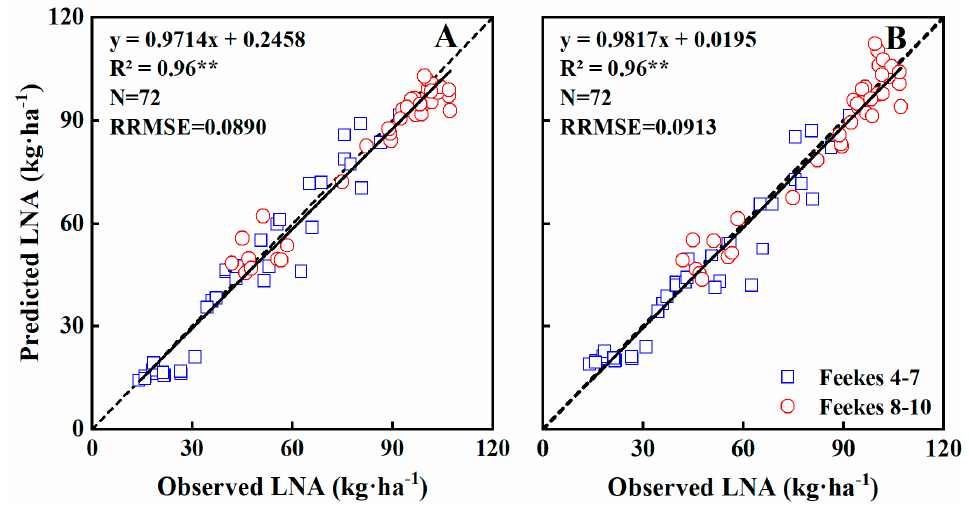
Figure 9. The relationships between observed and predicted LNA values of wheat varieties based on NDVI ( A ) and RVI ( B ) models in the Experiment 4 during vegetation growth period. The dotted line is inclined at 45°to the axes.